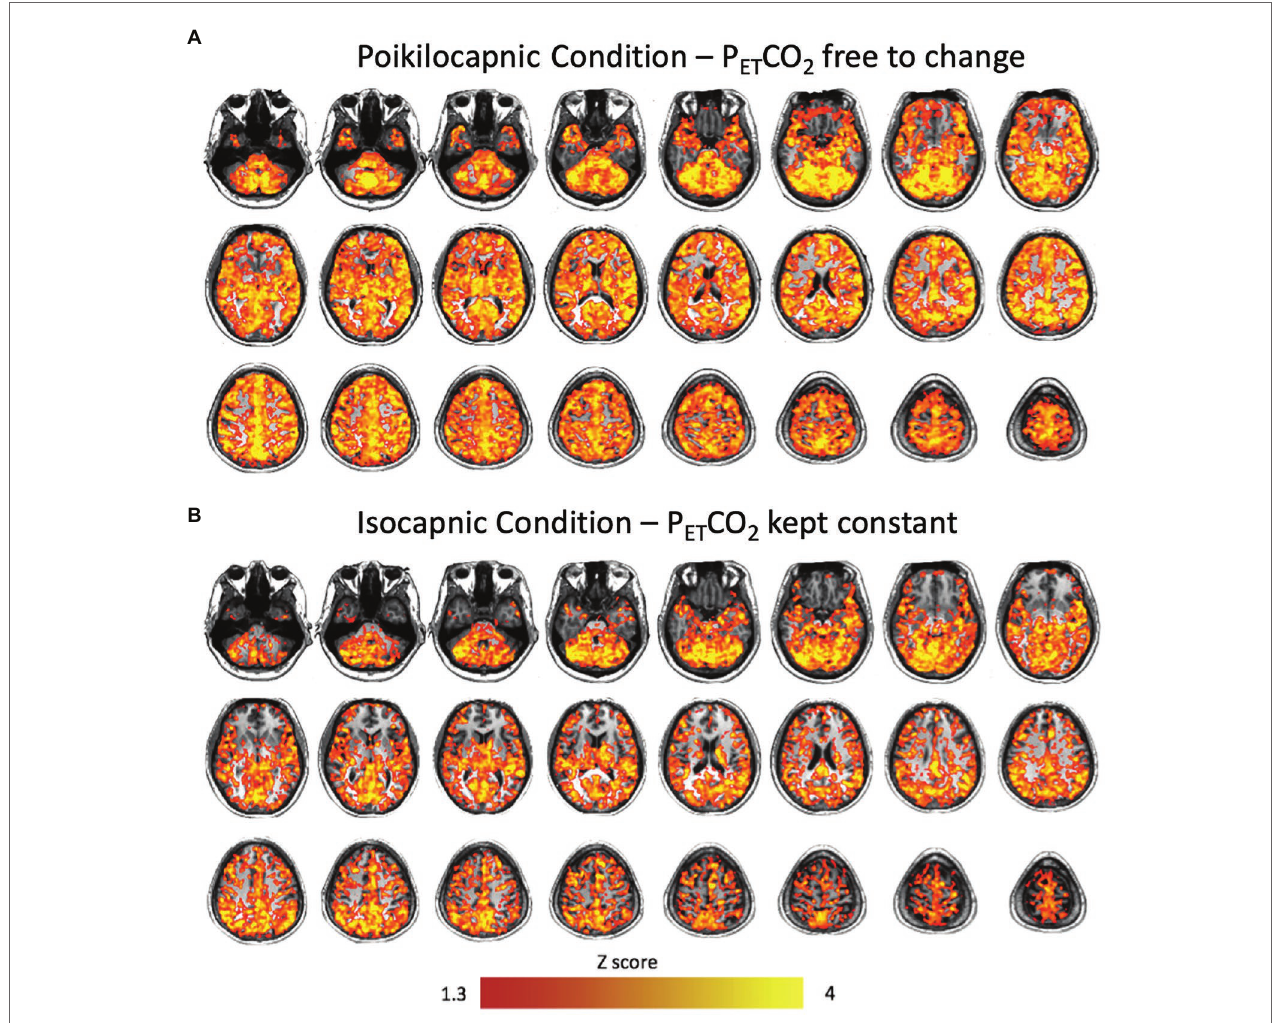
FIGURE 5 | Brain average maps displaying the correlations between the BOLD signal and P ET CO 2 time course during resting states in (A) the poikilocapnic condition, and (B) the isocapnic